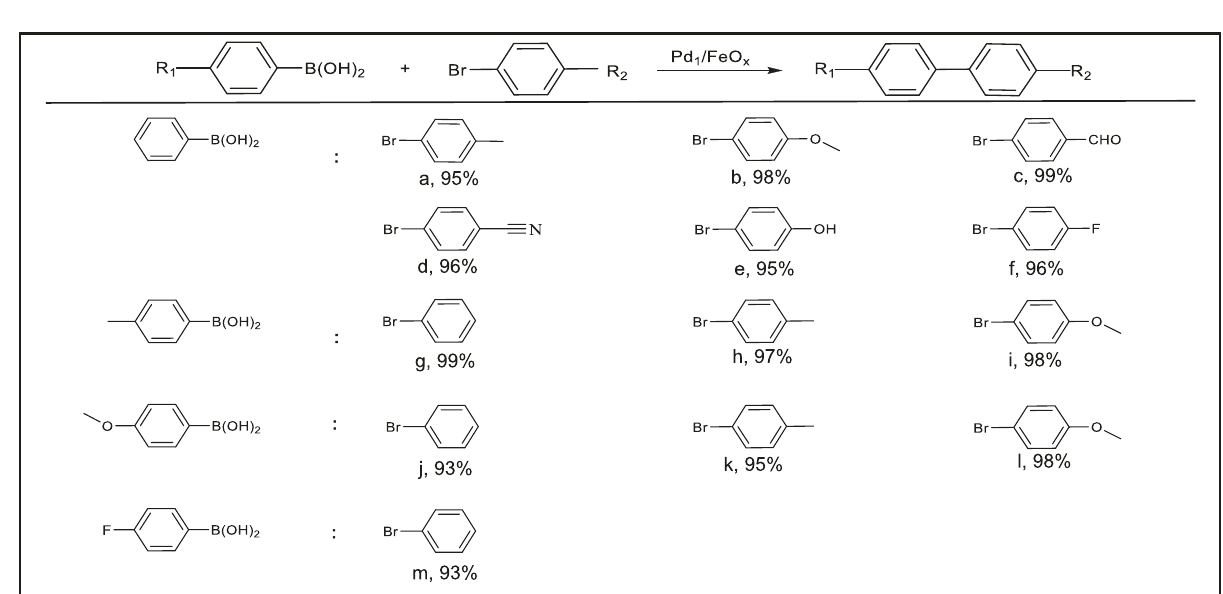
Fig. 5 | Catalytic properties of Pd 1 /FeO x in Suzuki – Miyaura cross-coupling reaction. a , b Suzuki – Miyaura cross-coupling catalyzed by 19 SACs and different commercial Pd catalysts, respectively. Reaction conditions: 5mg catalyst, bromo- benzene (0.5mmol), phenylboronic acid (0.75mmol), K 2 CO 3 (1.5mmol), solvent (2mL EtOH+4mL H 2 O), 40°C, decane as internal standard, biphenyl yields <30%. c Recycling experiments over Pd 1 /FeO x -1. Reaction conditions were identical as a , except the amount of catalyst was 10mg and the time was 2h. d Catalytic per- formanceof Pd 1 /FeO x -1,2,3,4atdifferenttemperatures.Reactionconditionswere